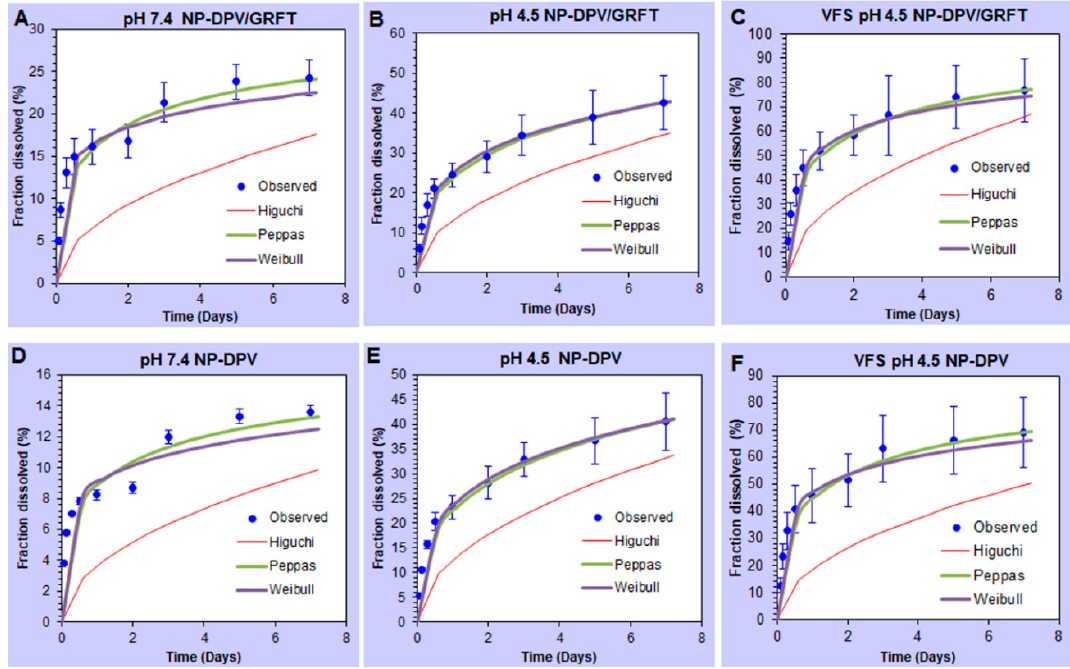
Figure 5. Mathematical model fitting of DPV release from PLGA nanoparticles. ( A – C ) DPV release from combination nanoparticles (NP-DPV/GRFT) at pH 7.4, 4.5 and VFS pH 4.5 media. ( D – F ) DPV release from single entity nanoparticles (NP-DPV) at pH 7.4, 4.5 and VFS pH 4.5 media. Dissolution profiles were fitted to Higuchi, Peppas, and Weibull models.